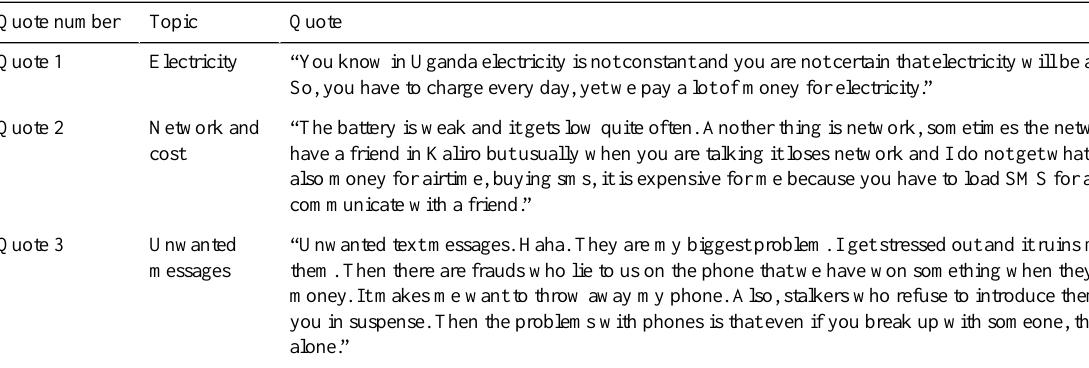
Table 2. Barriers to using phones